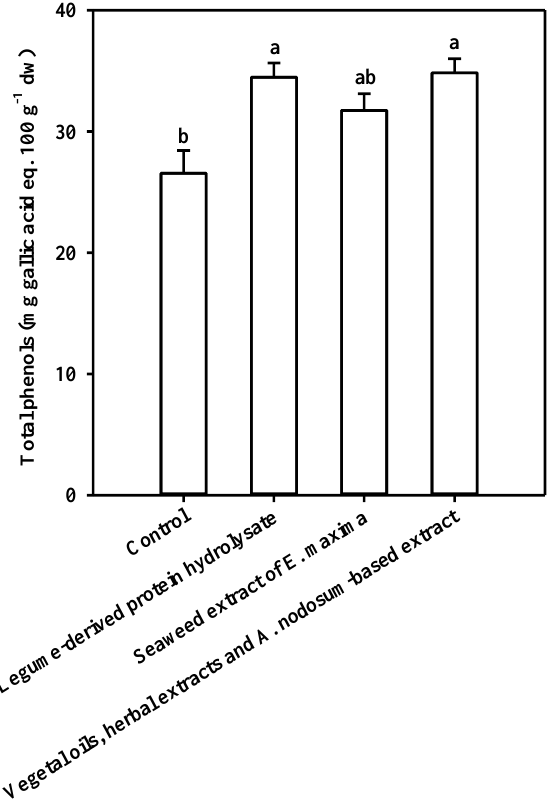
Figure 3. The effect of biostimulant treatments on total phenols content of leaves in greenhouse spinach plants. The values are means of three replicates. Vertical bars indicate ± SE of means. Different letters indicate significant differences according to Duncan’s test ( p < 0.05).